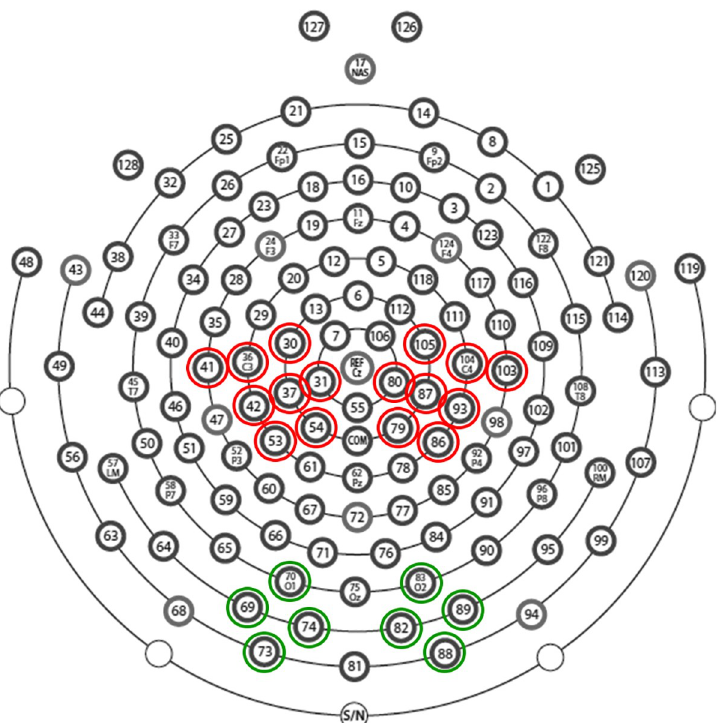
Fig 3. Hydrocel Geodesic Sensor Net– 128 channels map. Electrodes circled in red indicate central electrode-clusters of interest chosen to assess rolandic mu-rhythm modulation (electrodes 30, 31, 36, 37, 41,42, 53, 54 in left and 79, 80, 86, 87, 93, 103, 104, 105 in right). Electrodes circled in green indicate electrode-clusters of interest chosen to assess whether recordings in central areas might be affected by posterior activity (electrodes 69, 70, 73, 74 in left and electrodes 82, 83, 88, 89 in